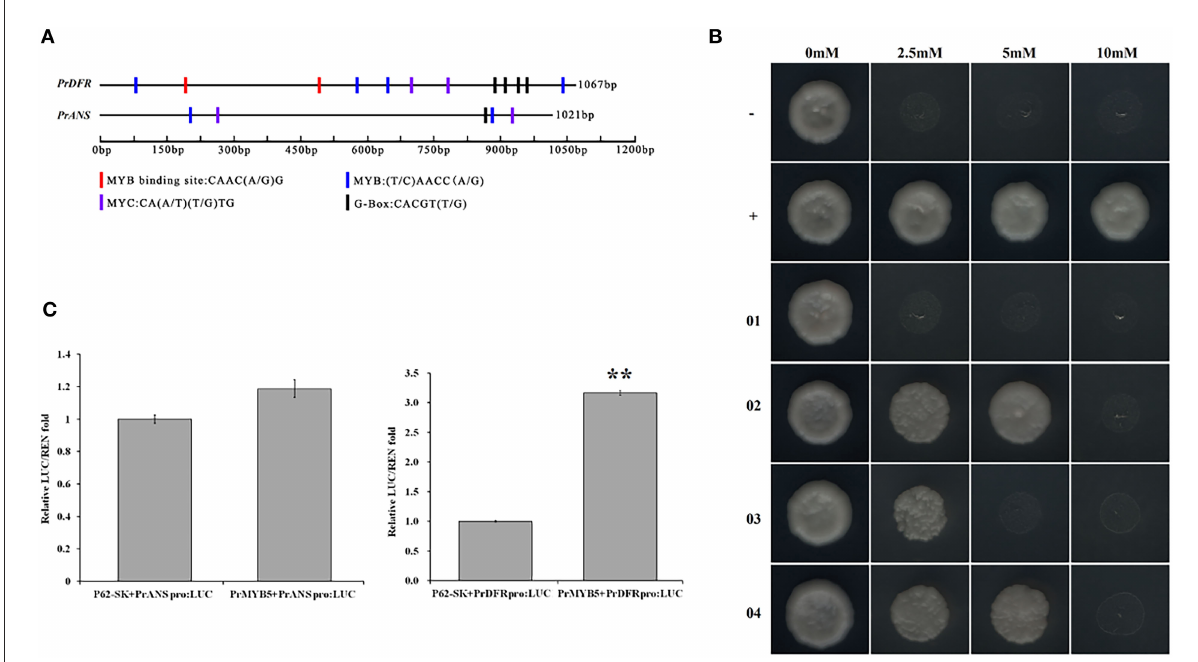
FIGURE7 Transcriptional activity analysis of PrMYB5 against the promoters of PrDFR and PrANS . (A) Schematic overview of PrDFR and PrANS promoters. The lengths, MYB binding sites, MYB sites, MYC sites, and G-box sites are marked with black solid lines and colored rectangles, respectively. (B) Recombinant yeast on the SD medium without His, Leu, and Trp with 0mM, 2.5mM, 5mM, and 10mM indicate the SD medium without His, Leu, and Trp with 3-AT at concentrations of 0, 2.5, 5, and 10mM, respectively. -, a negative control (pGADT7 + p53::pHis2); + , a positive control (pGADT7::53 + p53::pHis2); 01, pGADT7 + PrDFR ::pHis2; 02, PrMYB5 ::pGADT7 + PrDFR ::pHis2; 03, pGADT7 + PrANS ::pHis2; 04, PrMYB5 ::pGADT7 + PrANS ::pHis2. (C) Dual-luciferase assay in tobacco leaves. ** Indicates relatively significant differences at P <